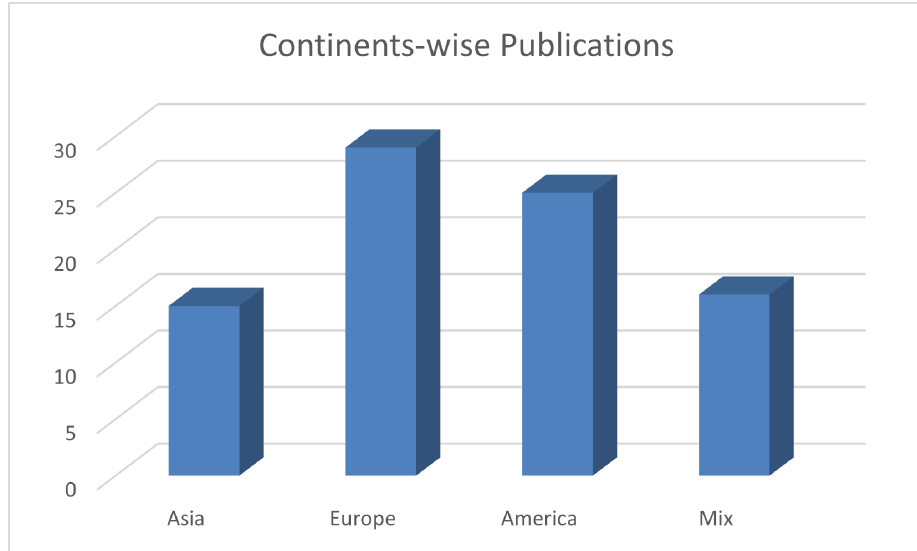
Figure 4. Publications by